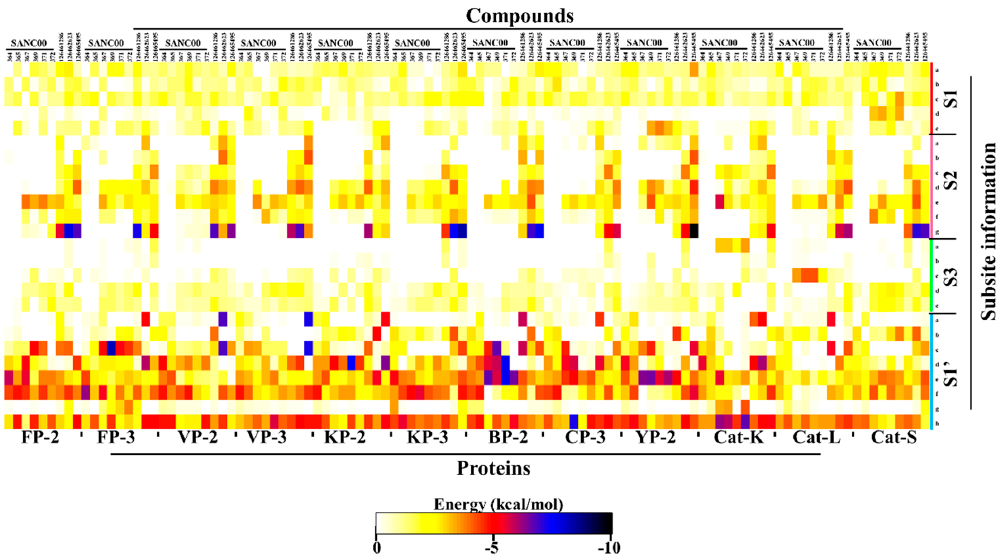
Figure 7. Per-residue decomposition of the net binding free energy (BFE) showing the contributions from each subsite residue towards ligand binding. The details (name and number) of the subsite residues (shown in letters) are listed in Table A6.